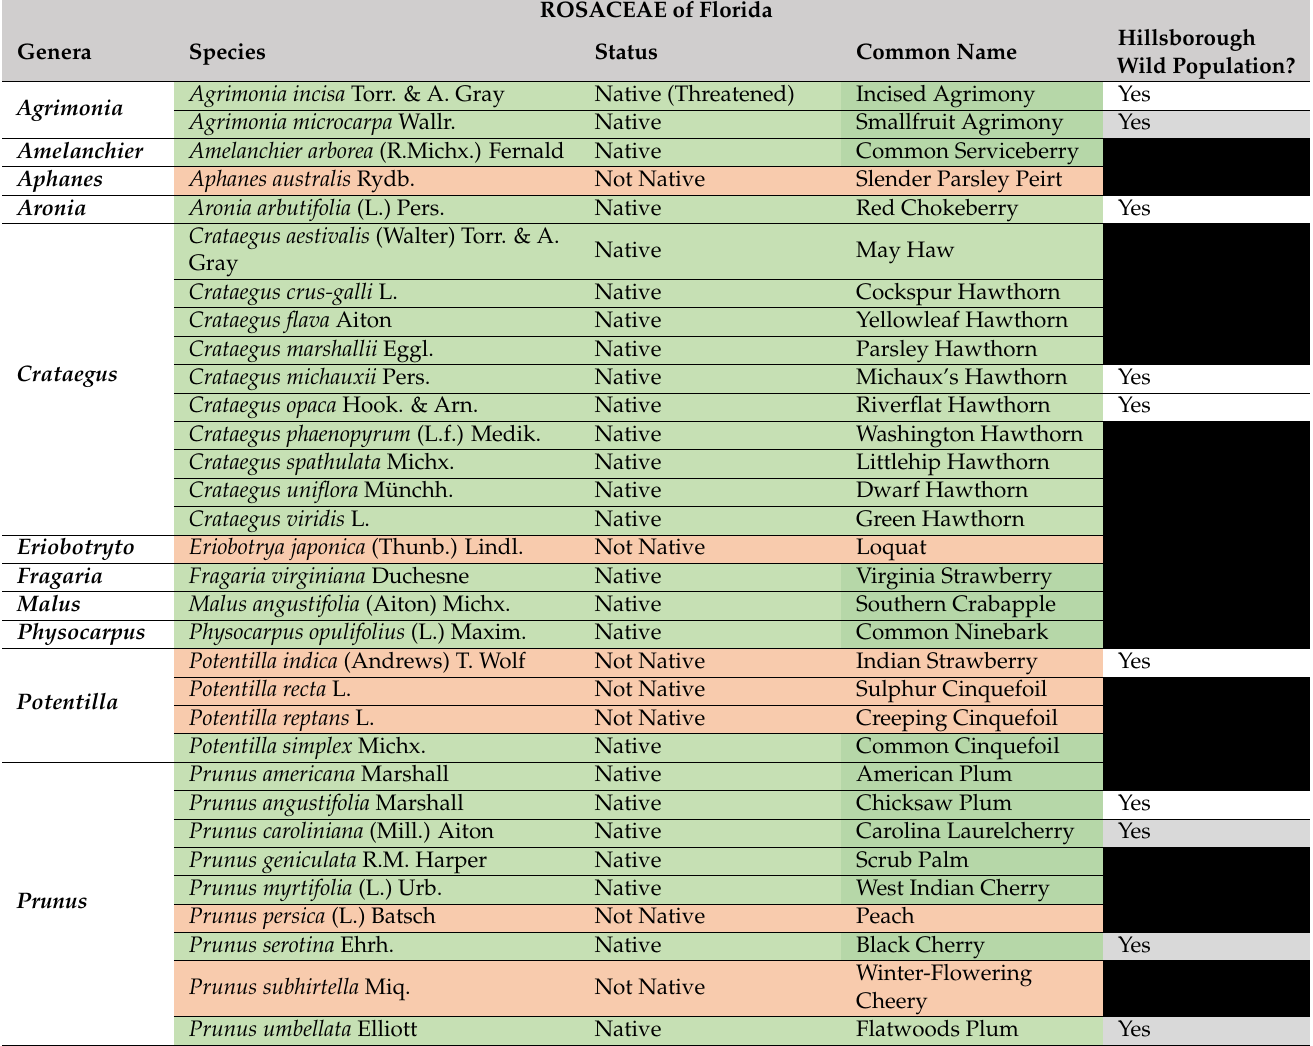
Table 3. Rosaceae Family Plant Genera in Hillsborough County, Florida, United